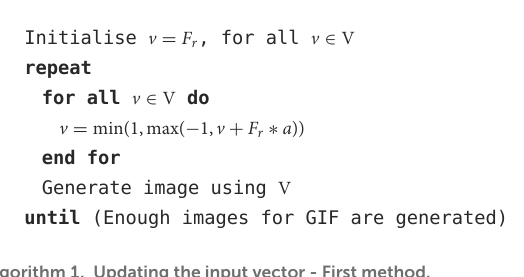
Algorithm 1. Updating the input vector - First method.